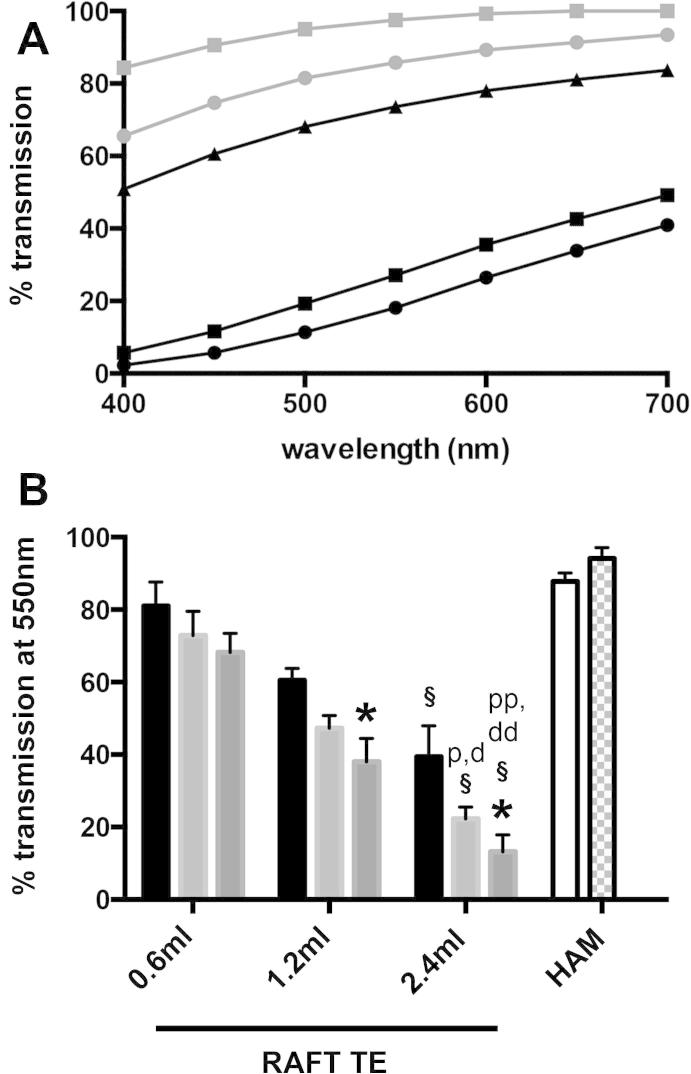
Light transmission through RAFT TEs and HAM samples. A: transmission (400–700 nm) through RAFT TEs produced using either 2.4 ml of 3 mg/ml collagen (black circles), 2.4 ml of 2 mg/ml collagen (black squares) or 0.6 ml of 3 mg/ml collagen (black triangles) was compared to transmission through proximal HAM samples (grey circles) and distal HAM samples (grey squares). For clarity, this figure shows data from a single, typical RAFT TE construct for each condition and one typical HAM donor. B: transmission (550 nm) through RAFT TEs produced using volumes of 0.6 ml, 1.2 ml or 2.4 ml of 1 mg/ml collagen (black bars), 2 mg/ml collagen (light grey bars) or 3 mg/ml collagen (mid grey bars), and proximal (white bar) and distal (checkerboard bar) HAM samples. Data are averages from 3 experimental repeats ±SD. ∗p < 0.05 compared to RAFT TEs produced using the same volume of collagen but 1 mg/ml collagen. §p < 0.05 compared to RAFT TEs produced using the same concentration of collagen but 0.6 ml volume. d p < 0.05, dd p < 0.01 compared to distal HAM samples. p p < 0.05, pp p < 0.01 compared to proximal HAM samples.